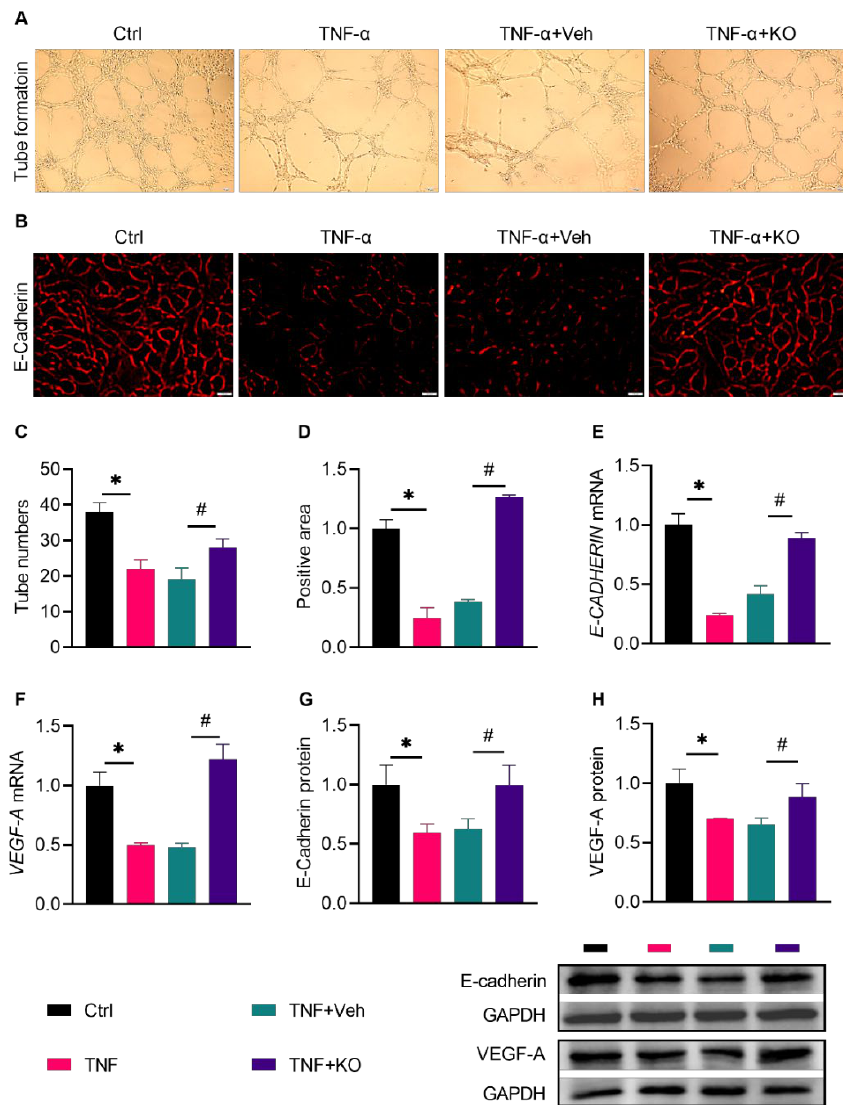
Figure 8. KO induced angiogenesis in TNF-treated ECs. ( A ) The matrigel tube formation assay and ( B ) immunofluorescent staining of E-Cadherin were performed to verify the effect of KO on angiogenesis in TNF-α-treated ECs. ( C ) The number of tube formation. ( D ) E-Cadherin positive area quantified from the immunofluorescence. ( E ) E-CADHERIN mRNA levels. ( F ) VEGF-A mRNA levels. Protein levels of ( G ) E-Cadherin and ( H ) VEGF-A. The data were summarized as means ± SD. *, p < 0.05 vs. Ctrl; #, p < 0.05 vs. DM. The abbreviations are the same as in Figure 7.